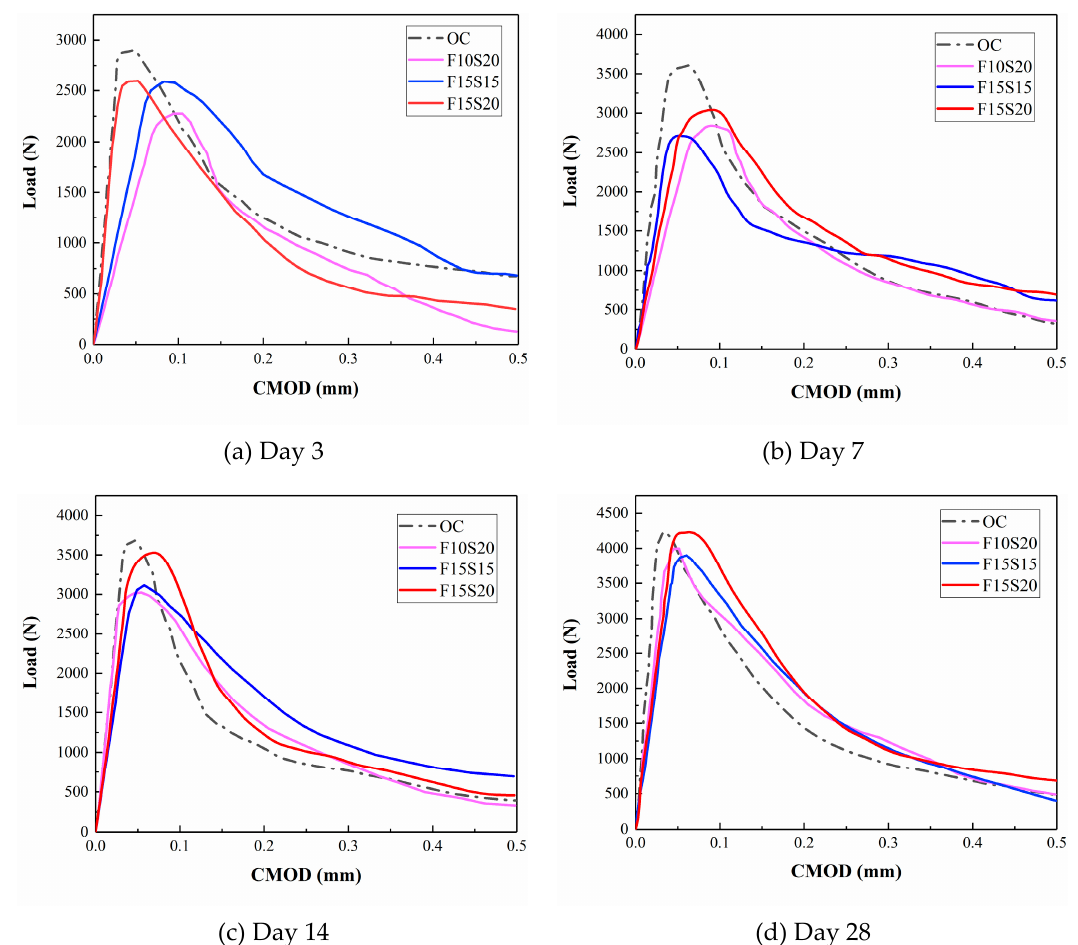
Figure 9. P-CMOD curves of concrete at different ages: ( a ) day 3; ( b ) day 7; ( c ) day 14; ( d ) day 28. Figure 10a,b plot the variation curve of fracture toughness with age for concrete mixed with different mineral admixture content. It can be seen that the fracture toughness of concrete increased with age, the change trends of instable fracture toughness ( K S IC ) and initial fracture toughness ( K Q IC ) were the same, and the initial fracture toughness of concrete in each group on day 3 was between 0.6 and 0.7 MPa.m 0.5 . The differences between instable fracture toughness and initial fracture toughness were OC: 0.378, F10S20: 0.203, F15S15: 0.266, and F15S20: 0.266. In practical engineering, when cracks are created in con- crete, the larger this difference is, the greater the load required to carry the concrete struc- ture from cracking to instability and the greater the ability of the concrete to resist crack expansion. On day 14, the OC group had the greatest initial fracture toughness and the F15S20 group had the greatest instable fracture toughness. Combining the analysis of the concrete P-CMOD curves and the fracture toughness formulae, it is clear that the main reason is that these two groups developed their own strength rapidly and were subjected to higher loads at fracture. The relationship between the initial fracture load and the in- stable fracture load of the four groups of concrete on day 28 was F15S20 > OC > F10S20 > F15S15, with the F15S20 group having the greatest initial fracture load and instable frac- ture load, indicating that this group was the least likely to crack under the external loading and showed the best cracking resistance. Figure 10c plots the variation curve of fracture energy with age for concrete with different mineral admixture content. The increase in fracture energy with age for the OC